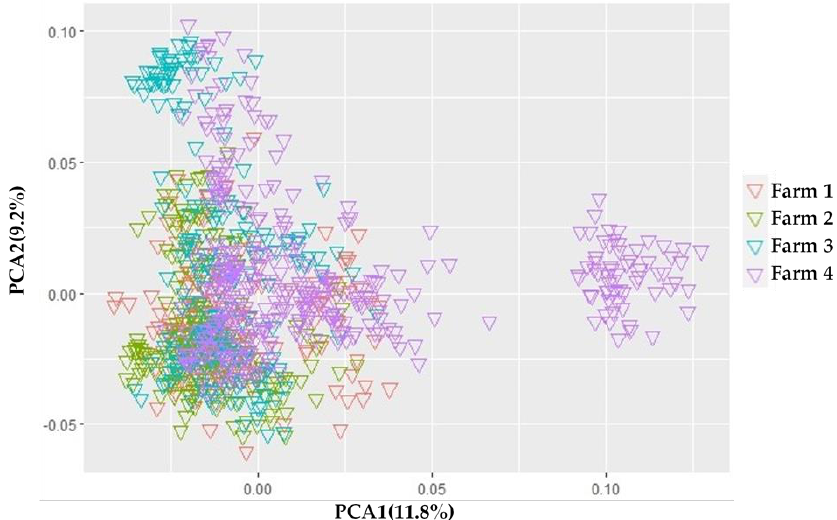
Figure 2. Population structure demonstrated by the 984 cattle raised at four animal farms. Principal component analysis (PCA).